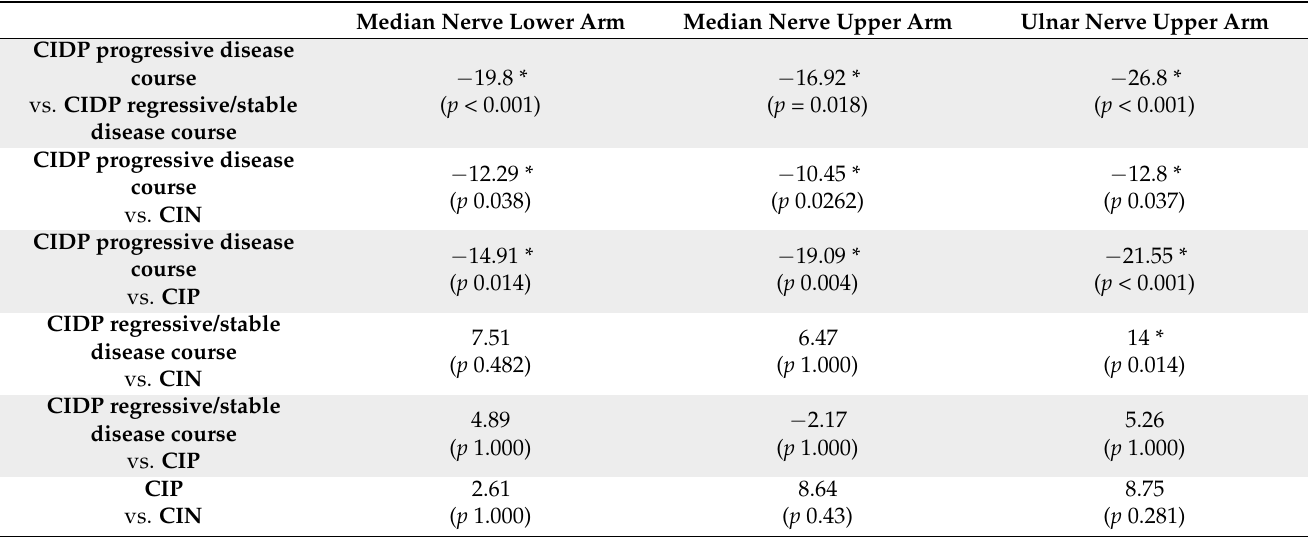
Table 3. Significant and non-significant differences in the Bonferroni-adjusted post hoc